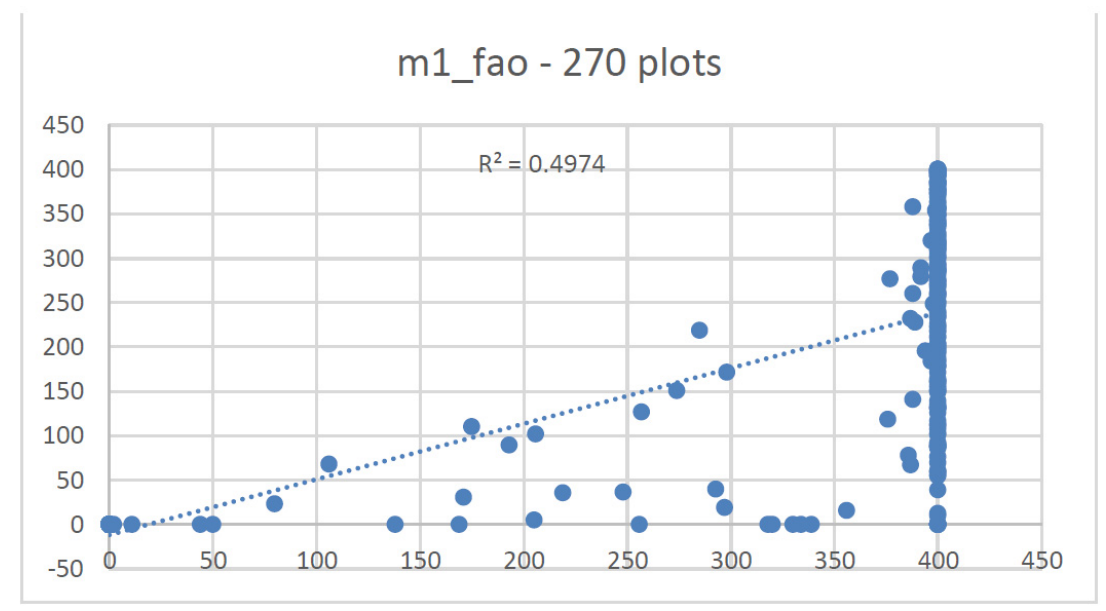
Figure A7. Reference area compared to estimated forest area by Method 1 for test plots (10 × 10 m 2 ) according to FAO/UN definition.